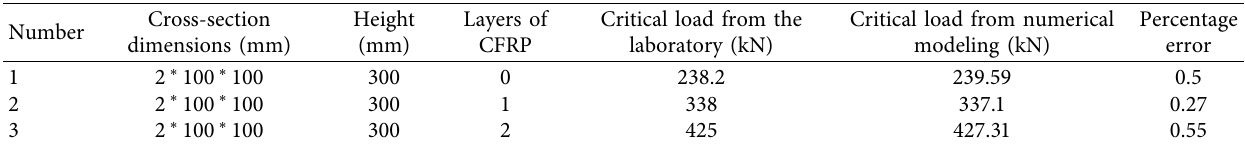
Table 1: Comparison of results obtained from laboratory samples and numerical modeling.